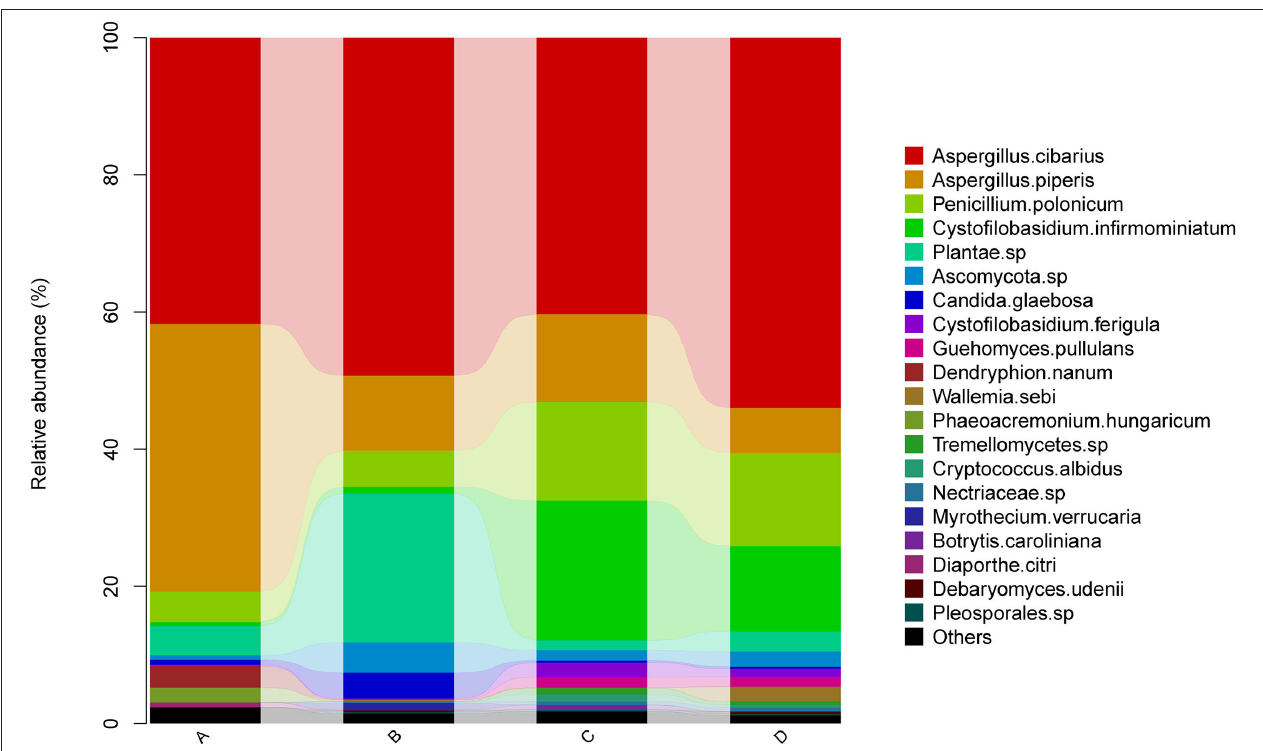
FIGURE 2 | Species levels in samples. membranaceus samples under fermentation with E. faecium (A), L. plantarum (B), E. faecium + L. plantarum (C), and LBS (D) on day